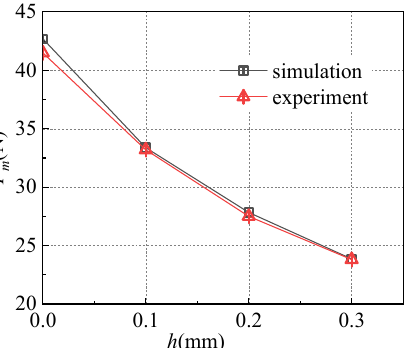
Figure 15. The experimental value is compared with the simulation under different working air gap.